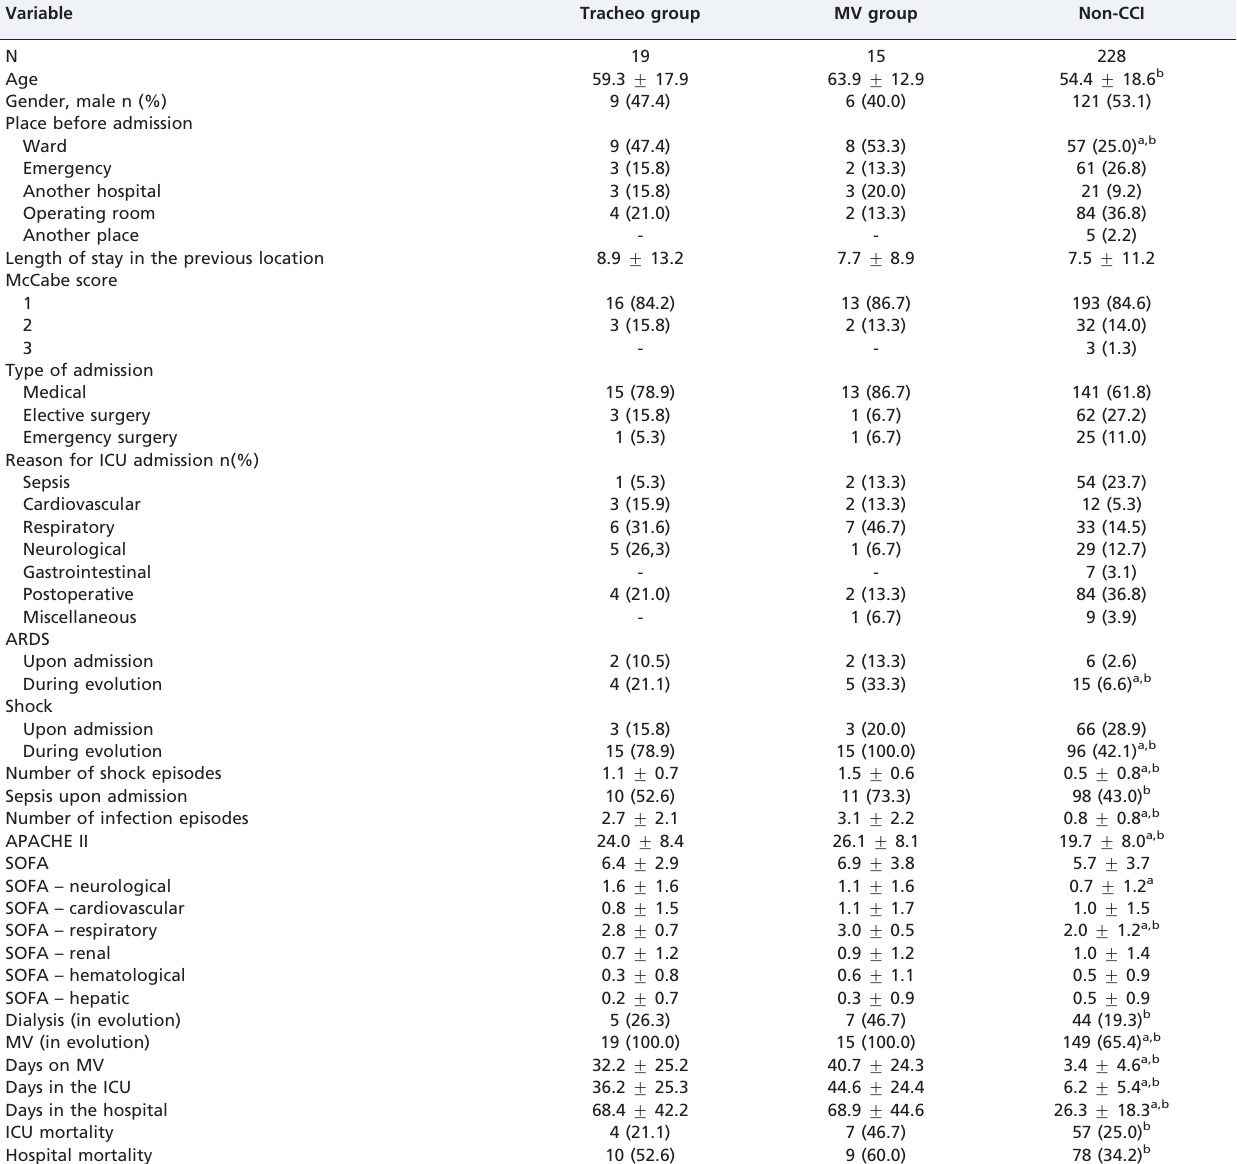
Table 1 - Clinical characteristics and outcome variables of CCI patients defined by either tracheostomy or MV for $ 21 days compared to the remainder of the patients in the